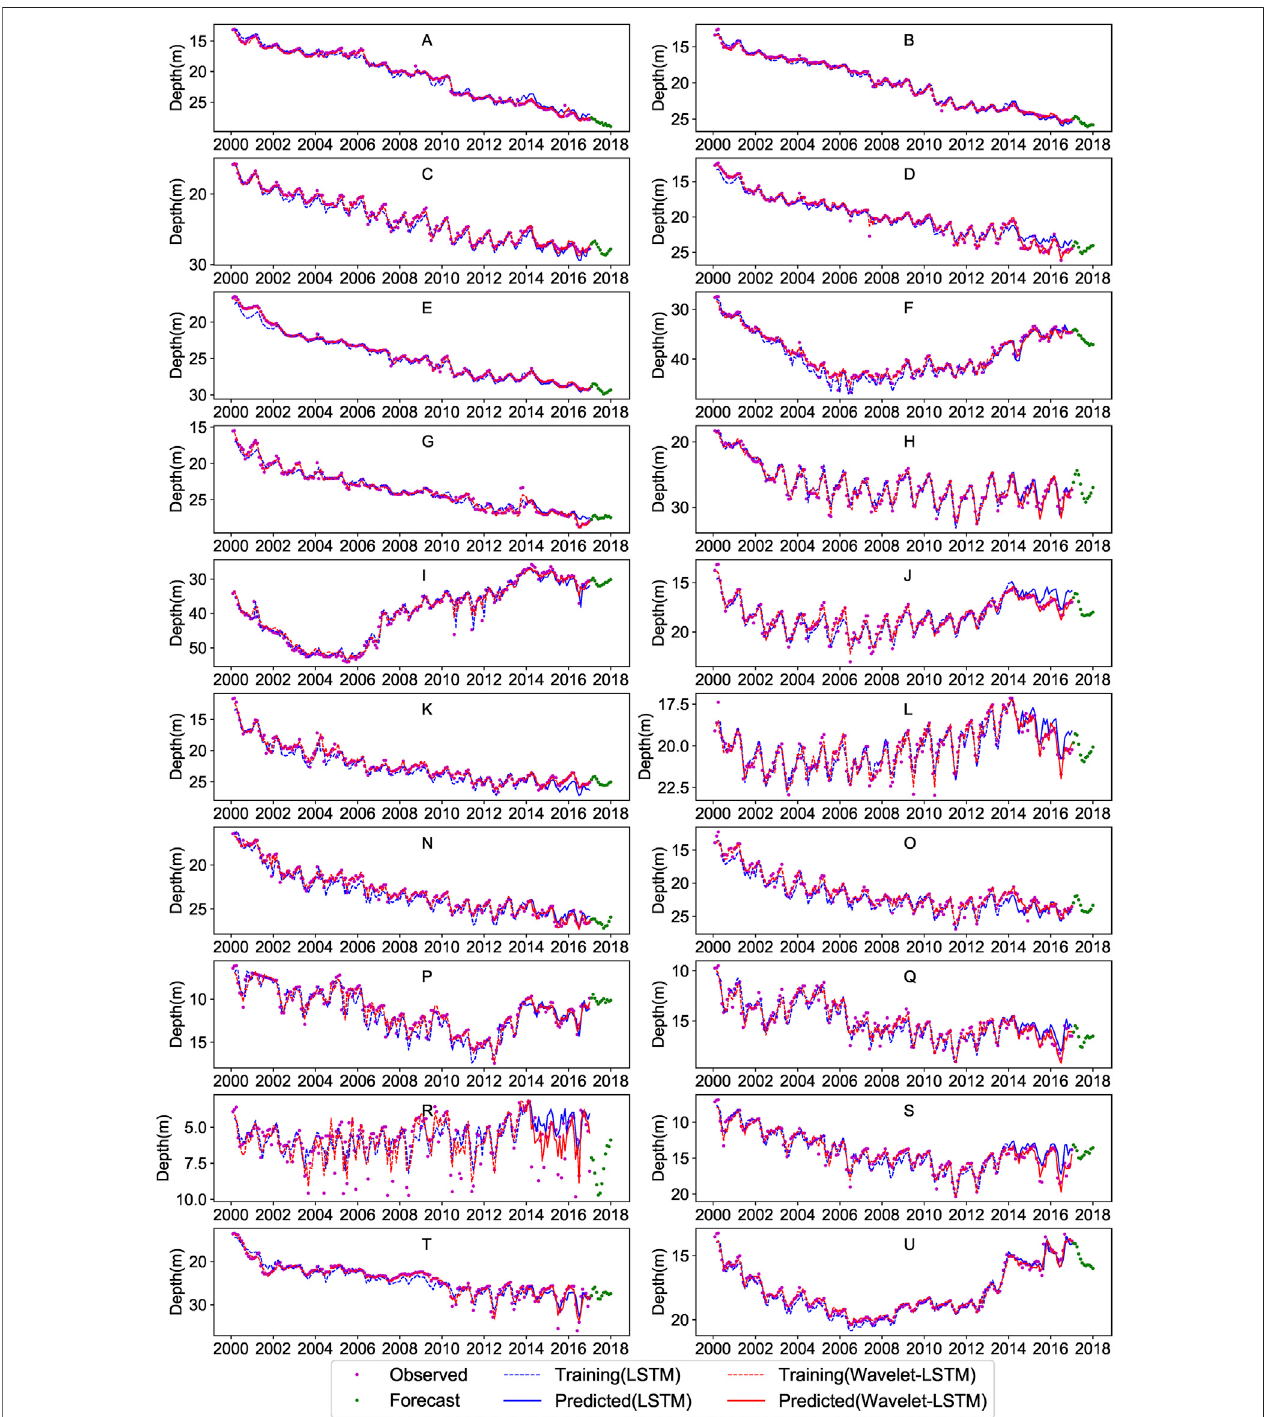
FIGURE 7 | Comparison of observed, simulated and forecast water table depth applied the single LSTM model and the wavelet-LSTM model at each site.